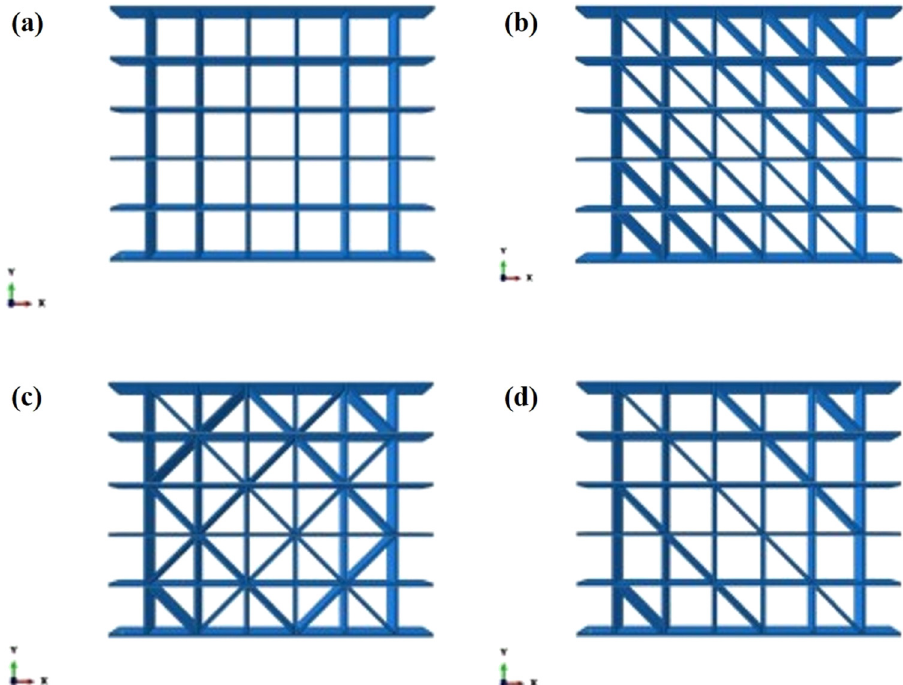
Figure 1: Models of four grid con fi gurations. ( a ) Quadrilateral con fi guration, ( b ) triangular con fi guration, ( c ) mixed con fi guration, and ( d ) diamond con fi